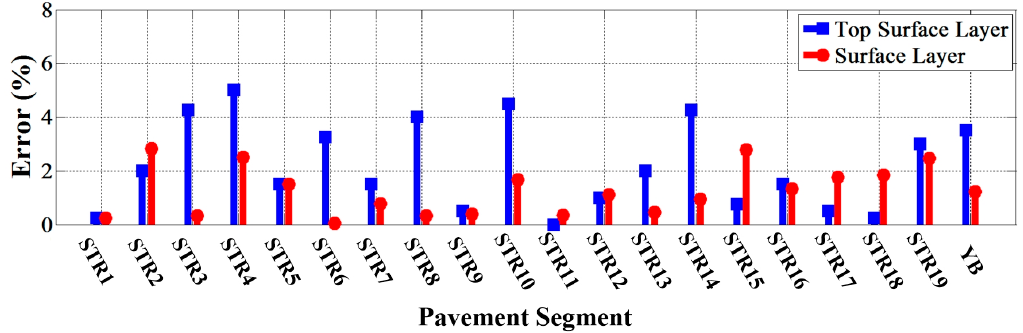
Figure 17. The estimated errors of each pavement segments.